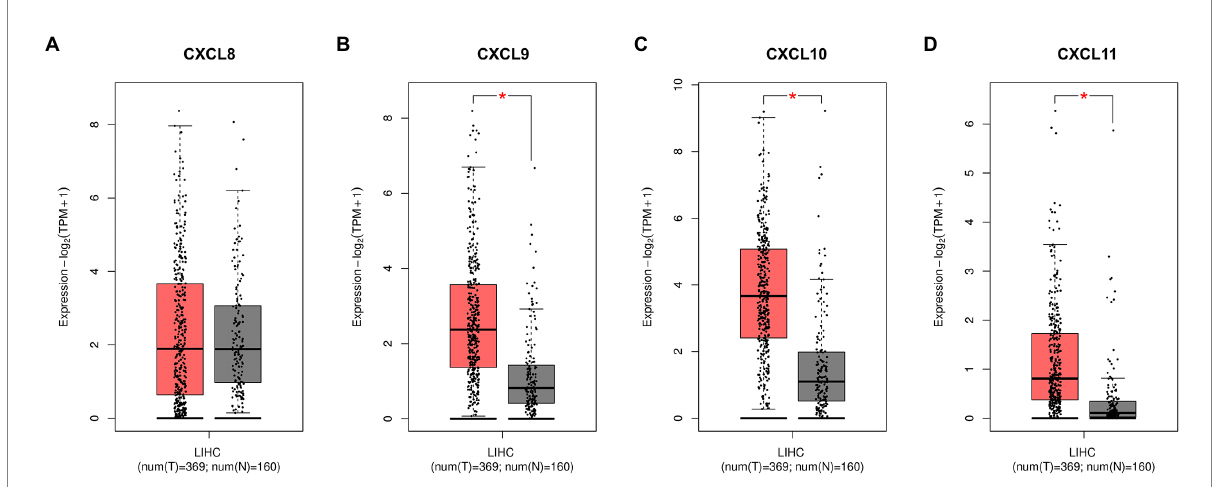
FIGURE 5 The differences of serum chemokines between normal tissues and HCC tissues. Differences in (A) CXCL8, (B) CXCL9, (C) CXCL10, and (D) CXCL11 levels between normal tissues and HCC tissues, based on GEPIA database. HCC tissue is shown in red and normal tissue is shown in gray. Expression-log 2 (TPM + 1) indicates the expression level of corresponding genes in HCC tissues and normal tissues. Asterisk (*) in red indicates p <